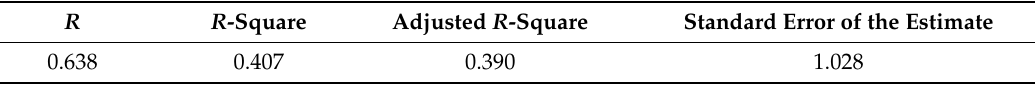
Table 16. Model summary.